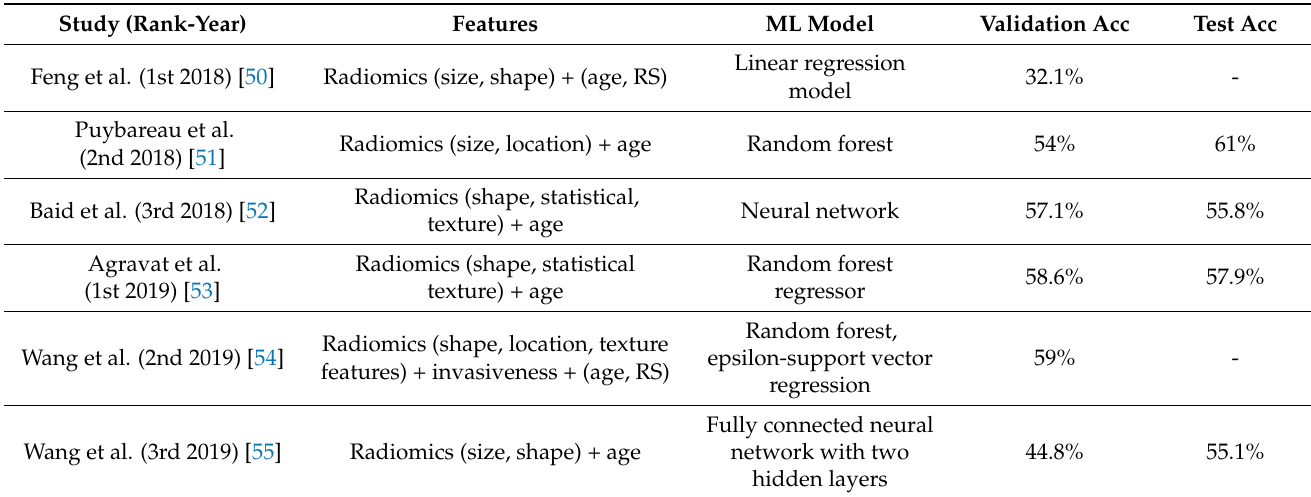
Table 1. State-of-the-art overall survival time prediction methods for glioblastoma patients using BraTS 2018 and 2019 datasets, where RS refers to the resection status and Acc refers to the accuracy. Study